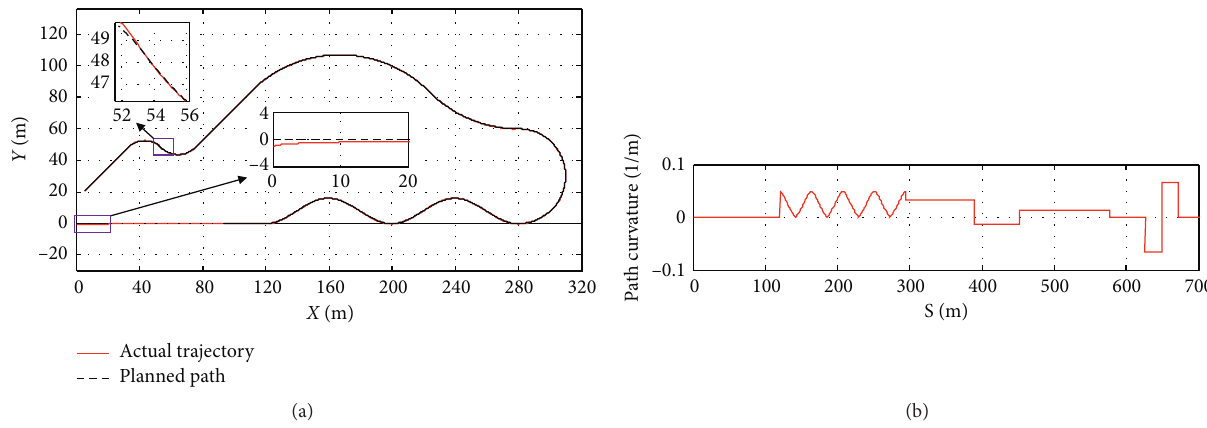
Figure 20: The trajectory of the path-following vehicle against with curvature variations of the